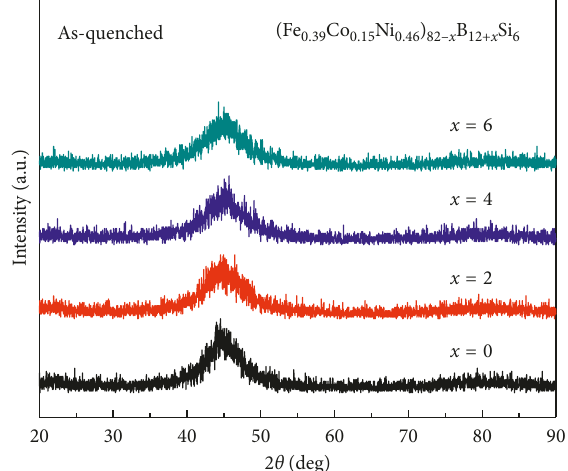
Figure 2: XRD patterns of (Fe quenched